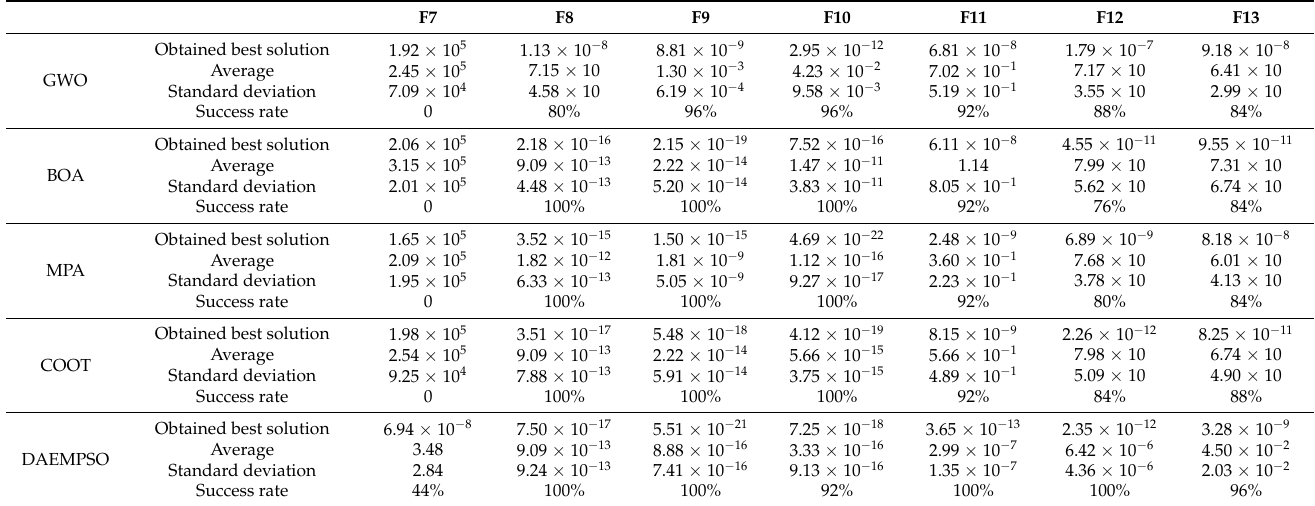
Table 6. Comparison of the optimization results of five algorithms for seven test functions (800